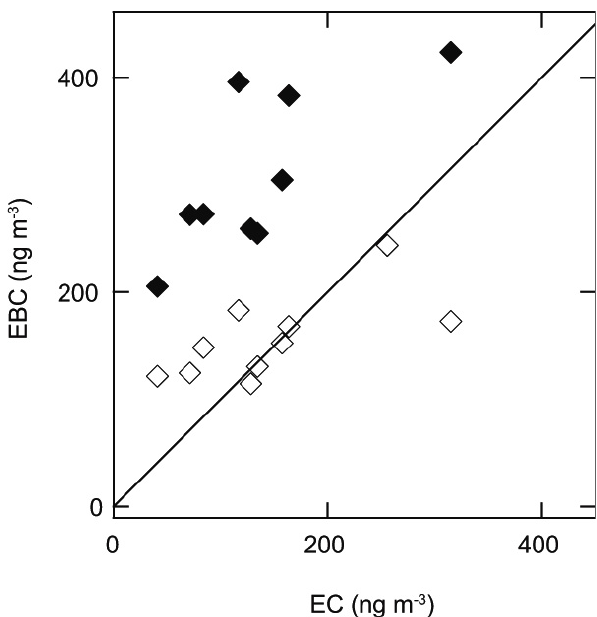
Fig. 3. Scatter plot of EBC concentration at Trinidad Head calcu- lated with σ ∗ equal to 10m 2 g − 1 (full diamonds) and 20m 2 g − 1 (open diamonds) versus the average EBC concentration at the IM- PROVE sites; black line indicates the 1:1